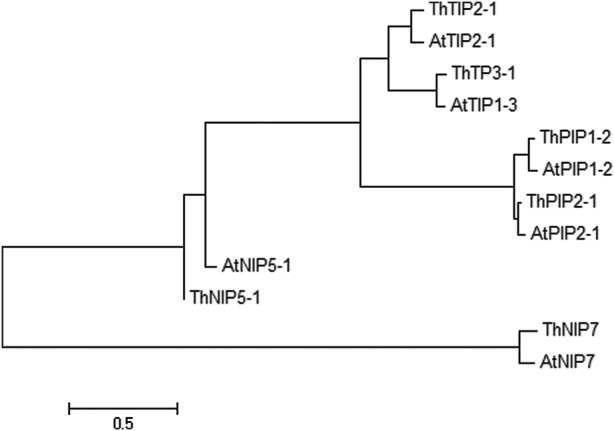
Phylogenetic relationship of the six AQPs in the T. ramosissima. The phylogenetic tree was constructed with maximum likelihood using the Jones–Taylor–Thornton (JTT) model in MEGA 6.0. At, Arabidopsis thaliana; Th, T. ramosissima. The distance scale is 0.5.